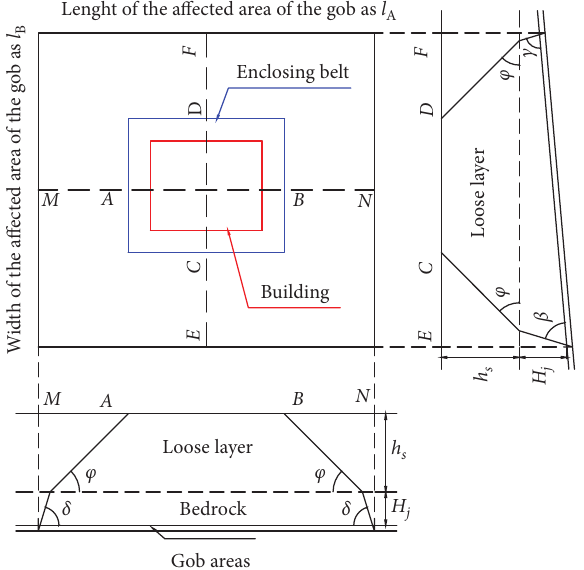
Figure 17: Vertical section method for determining the affected area of the gob φ , movement angle of loose layer; δ , strike movement angle of bedrock; c , uphill movement angle of bedrock; β , downhill movement angle of bedrock; h s , thickness of loose layer; H j , thickness of bedrock. Figure 18: Affected area below the office